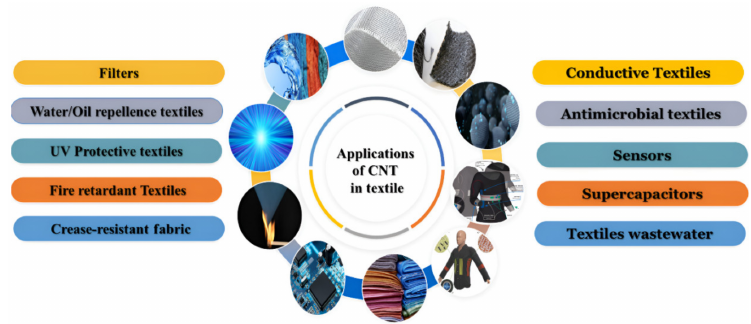
Figure 3. Potential applications for the use of carbon nanotubes in textiles.